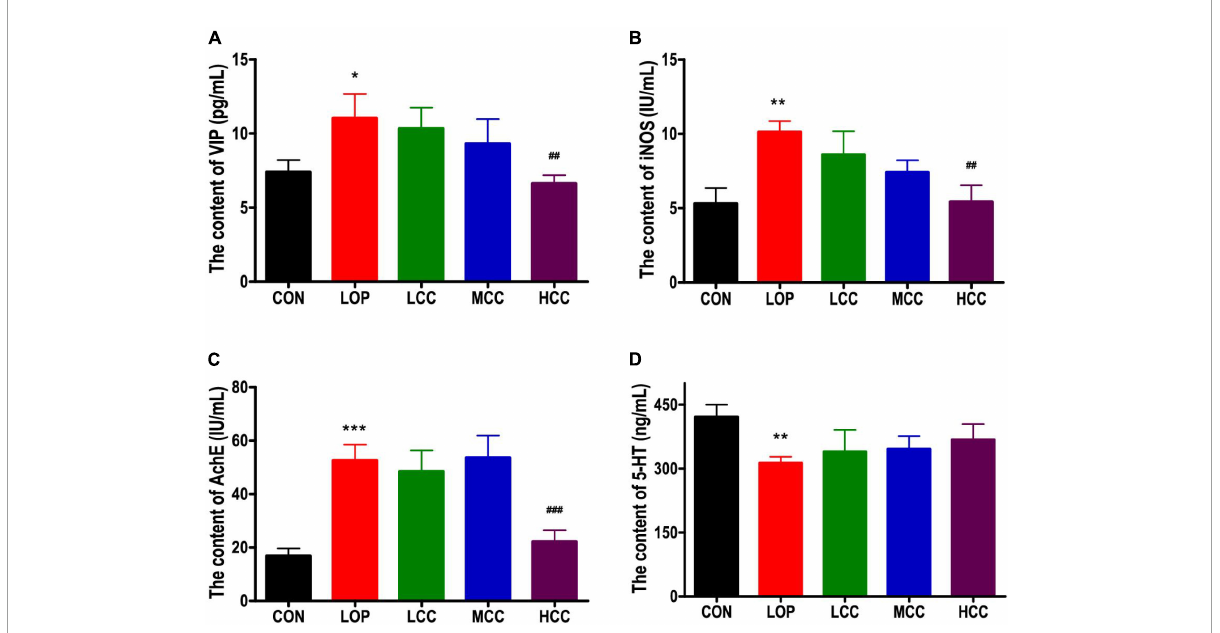
FIGURE2 (A) Vasoactive intestinal polypeptide (VIP), (B) induced nitric oxide synthases (iNOS), (C) acetylcholinesterase (AchE), and (D) serotonin (5-HT) in serum. The data are expressed as the means ± SEMs ( n = 8). *, compared with the CON group; #, compared with the LOP group. * P < 0.05; ** P < 0.01; *** P < 0.001; ## P < 0.01; ### P <